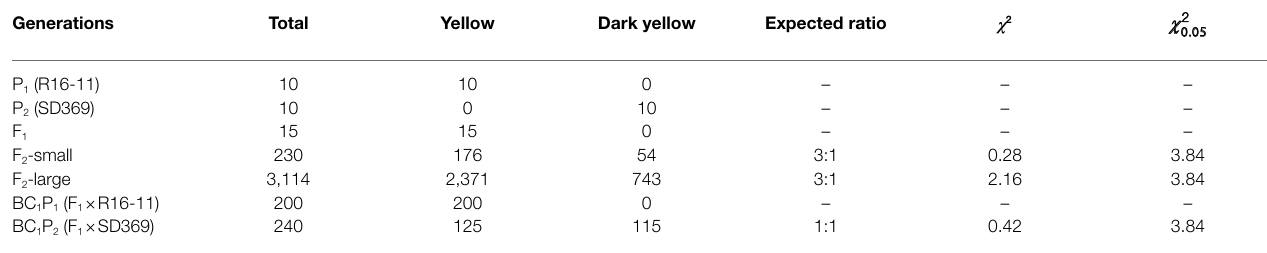
TABLE 1 | Genetic analysis of the petal trait in parents and in crosses between R16-11 and SD369. Generations